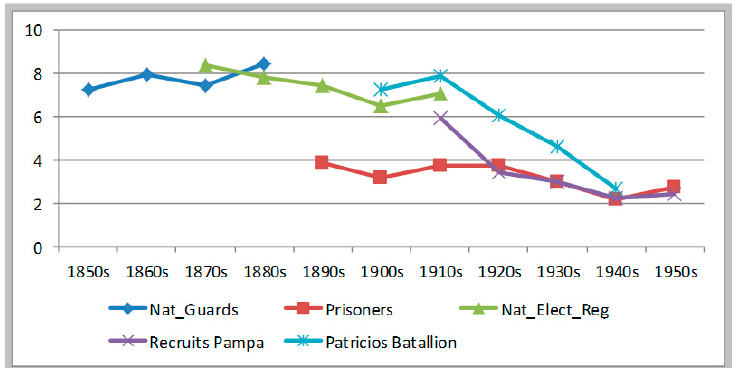
Figure 6. Evolution of malnutrition rates in Argentina (1850s to 1950s). Calculated based on Argentine 1987 standards.